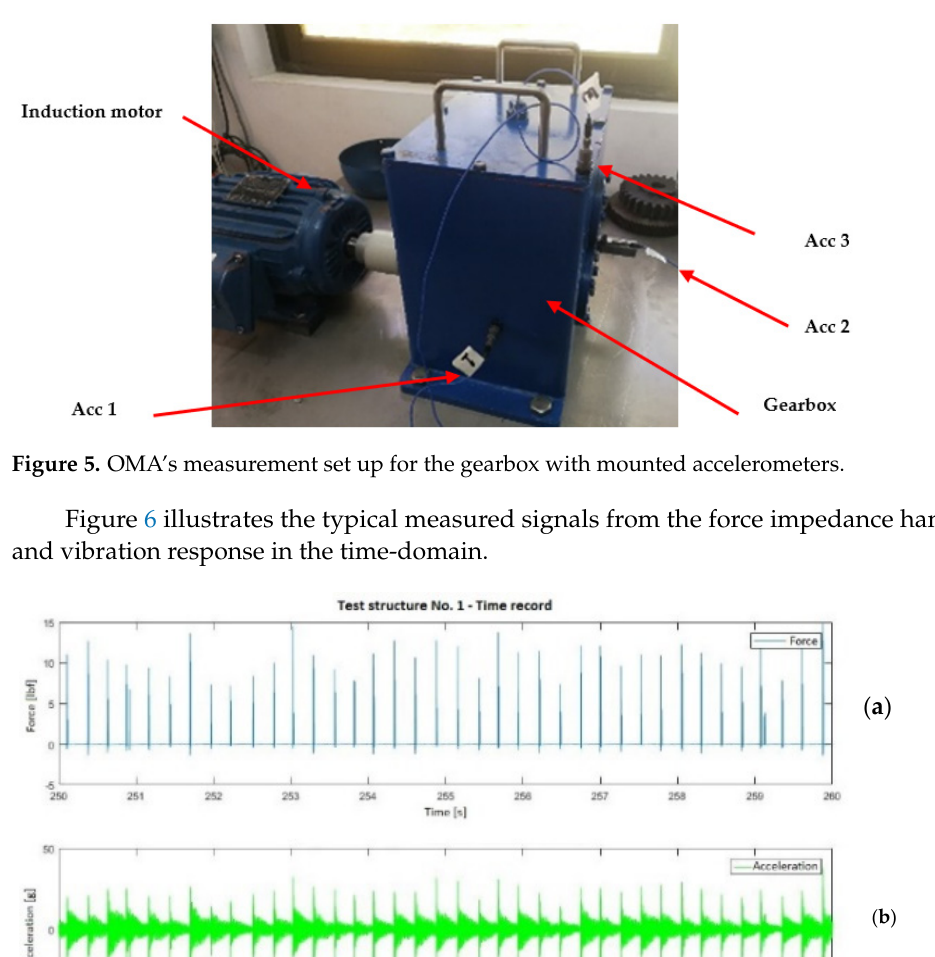
Figure 4. OMA’s measurement set up for the induction motor with mounted accelerometers.